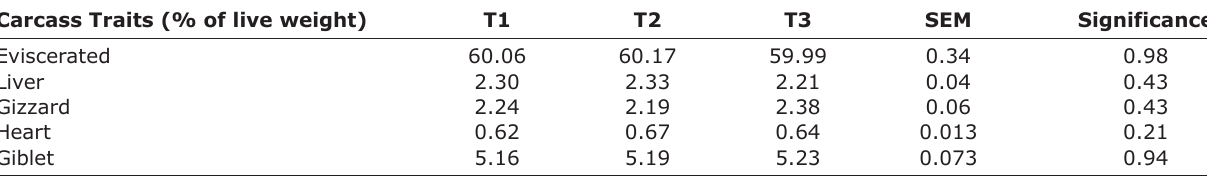
Table-3: Influence of dietary treatment on the carcass traits of